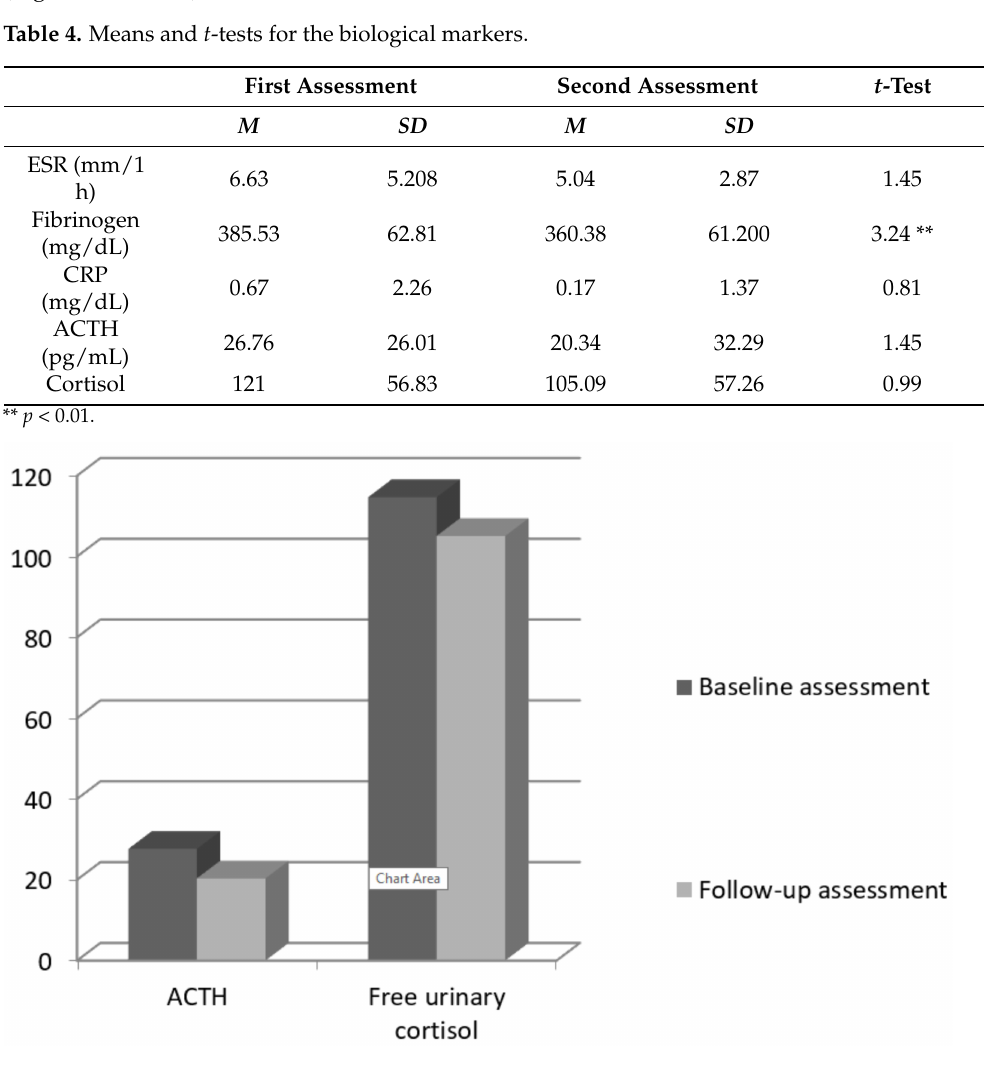
Figure 1. Baseline and follow-up means for ACTH and